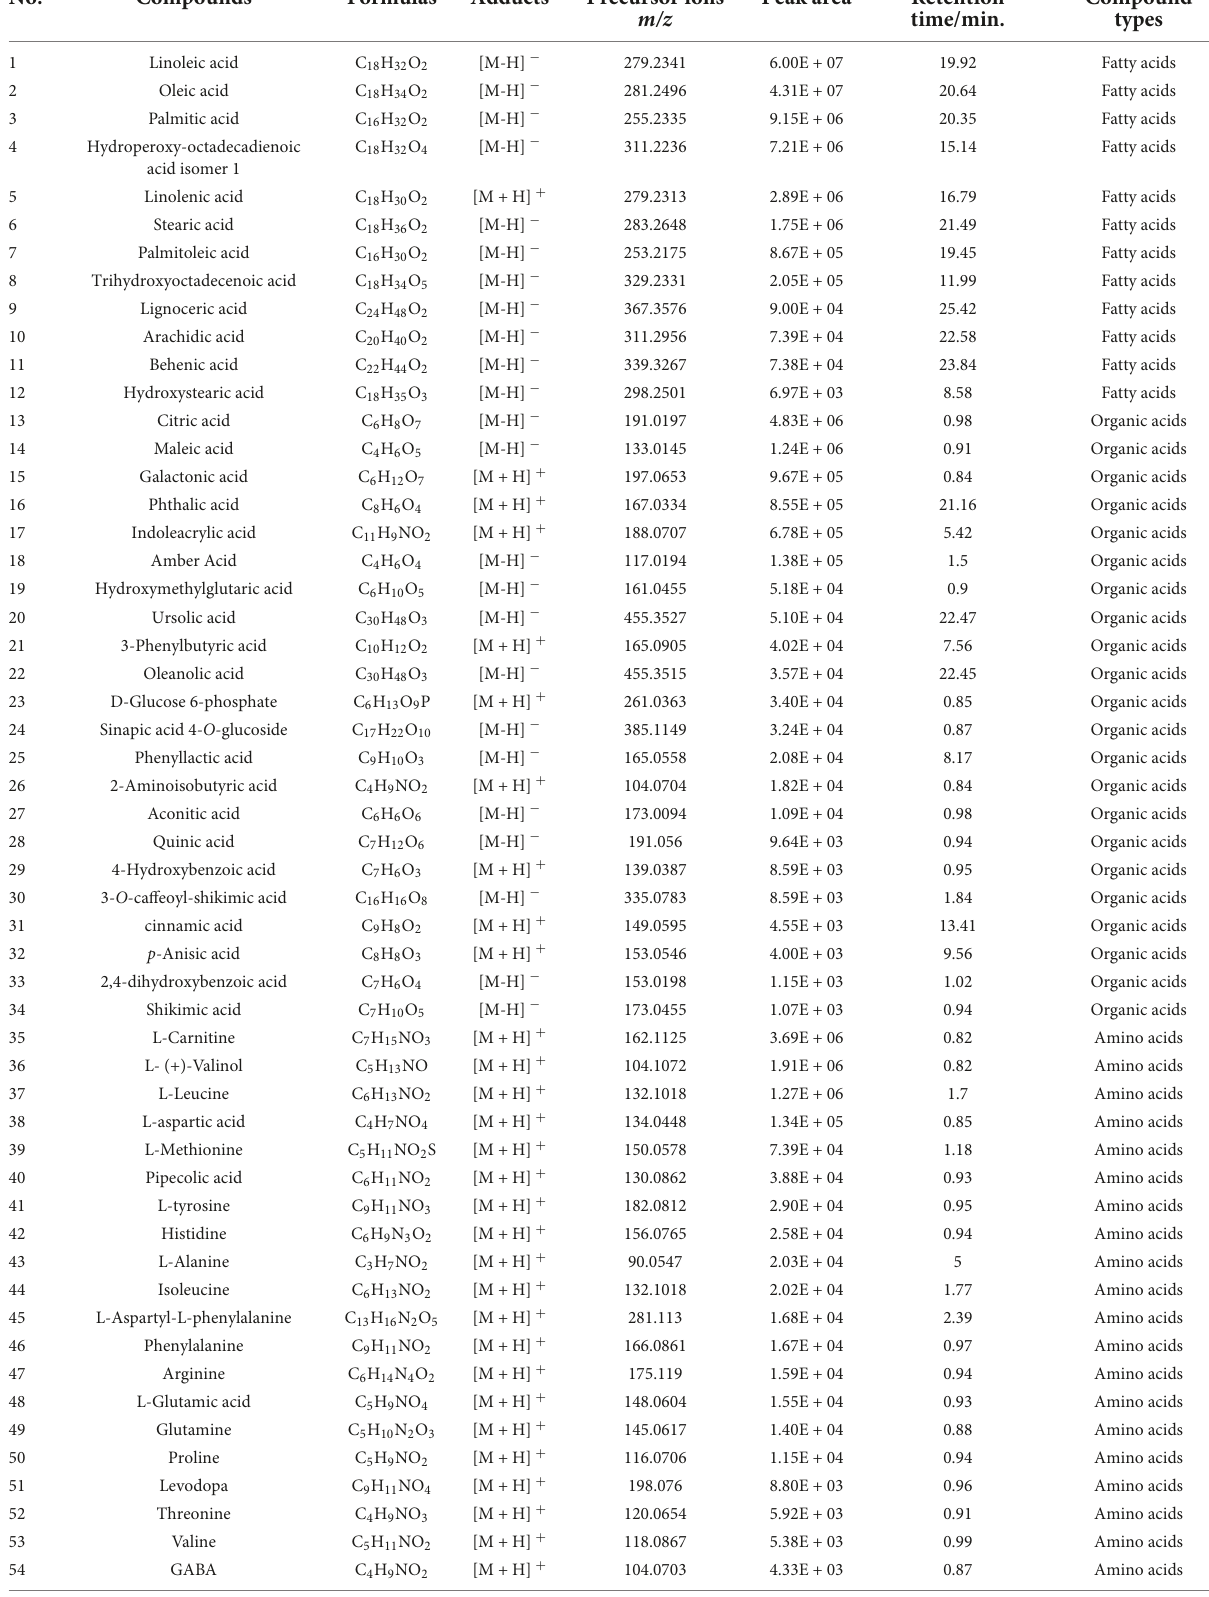
TABLE 1 Identification of components in Tremella aurantialba by UPLC-Q/TOF MS.